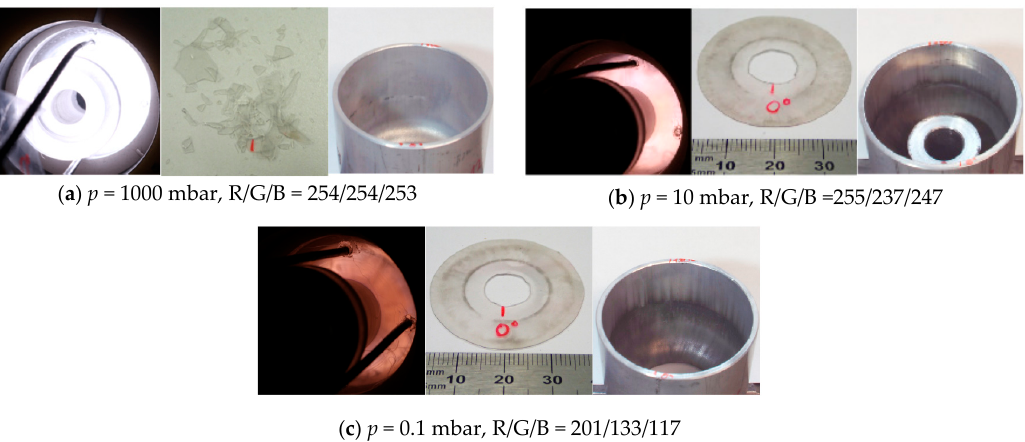
Figure 12. Long time exposures of the process glare, first plastic disc and flyer tube after MPW experiments at the Bmax setup ( l c = 3 mm, α = 0°, g = 1.5 mm, E = 4.5 kJ, I max = 365 kA, Ø coil = 41 mm, w c = 10 mm, l w = 6 mm): ( a ) p = 1000 mbar, ( b ) p = 10 mbar, ( c ) p = 0.1 mbar.